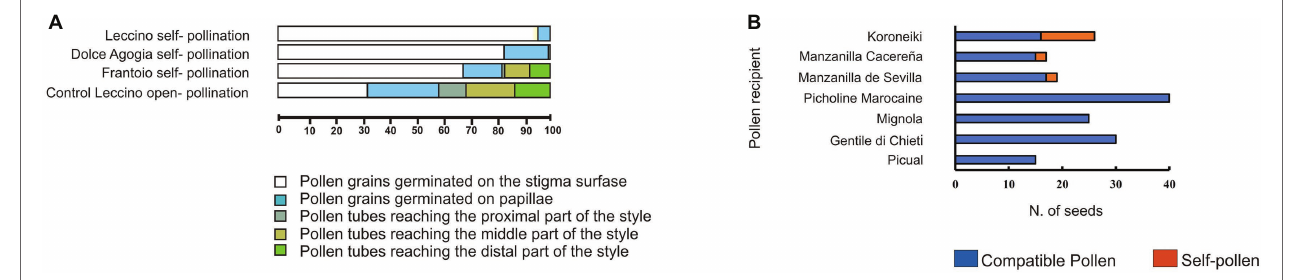
FIGURE 2 | Pseudo-self-compatibility data in olive cultivars. (A) Variation of pseudo-self-compatibility of three olive genotypes observed under field conditions. Percentage of pollen tubes germinated in different pistil tissues of cv. Leccino and Frantoio (G1 incompatibility group) and cv. Dolce Agogia (G2 incompatibility group) was determined analyzing a total of 34.000 pollen grains. Samples were collected at 6 days after anthesis in both self-pollinated and open-pollinated (control) flowers. Pollen grains were divided into five different classes (different colors). About 9.5% of cv. Frantoio self-pollen tubes grew through the transmitting tissues reaching the distal part of the style, indicating pseudo-self-compatibility. The few pollen grains of cv. Dolce Agogia, reaching the proximal part of the style, are presumably due to slight differences in the incompatibility response of the G2 incompatibility group compared to G1. (B) The number of seeds obtained from pollination with compatible and self-pollen in seven cultivars under field conditions. Paternity was validated by using microsatellite